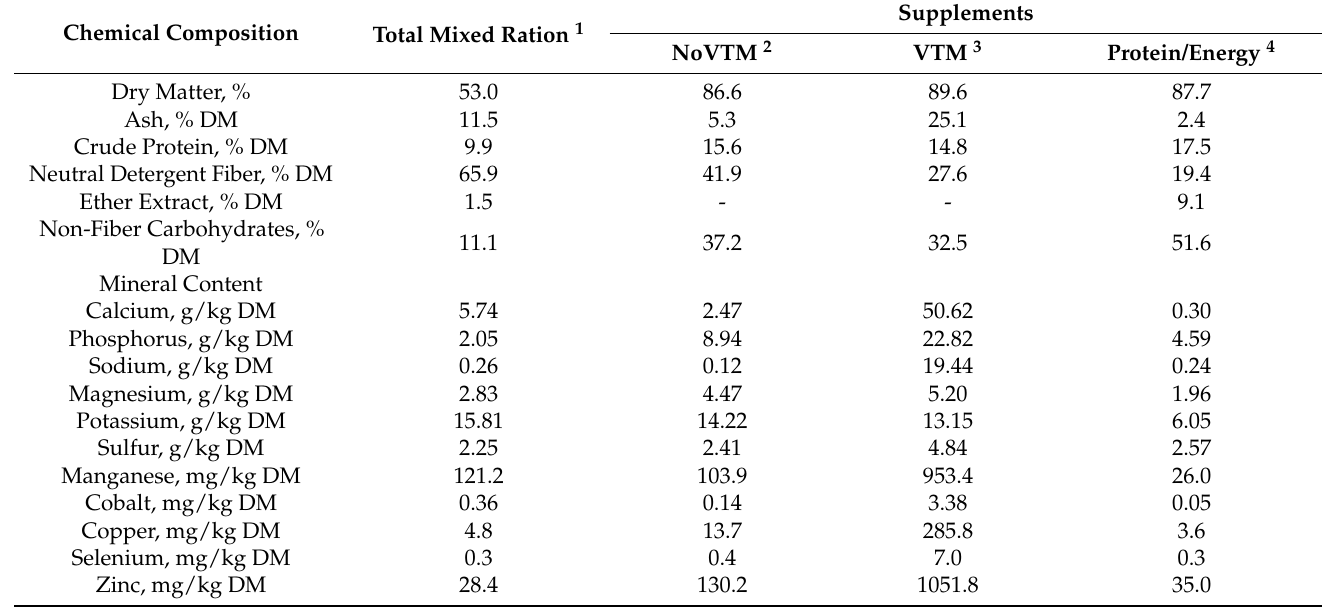
Table 2. Nutrient composition of total mixed ration and supplements provided to replacement beef heifers during the first trimester of